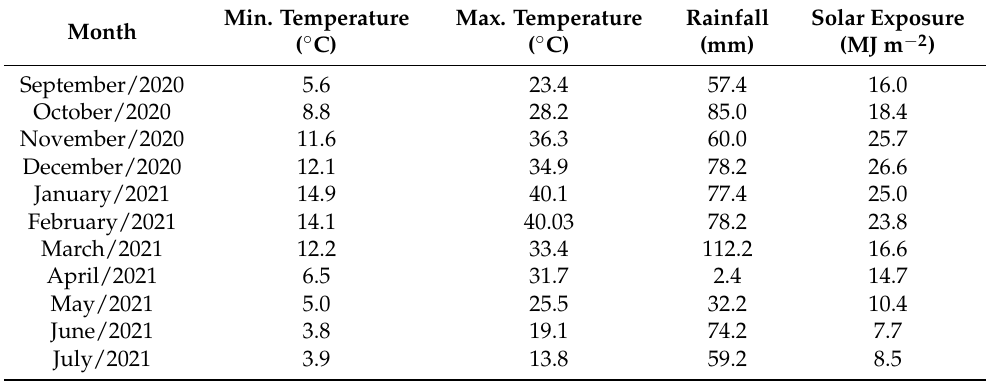
Table 3. Weather data (monthly average) at WWAI during experimentation